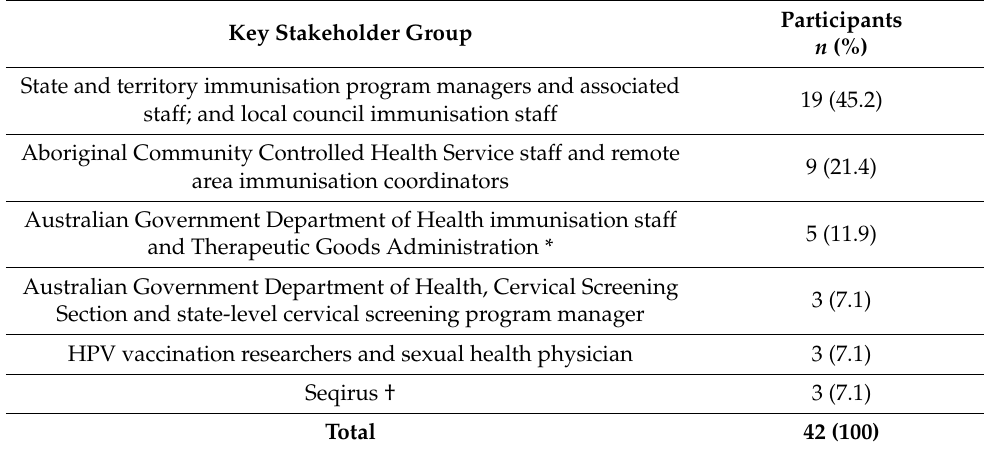
Table 1. Key stakeholder interview participants by stakeholder group. Key Stakeholder Group